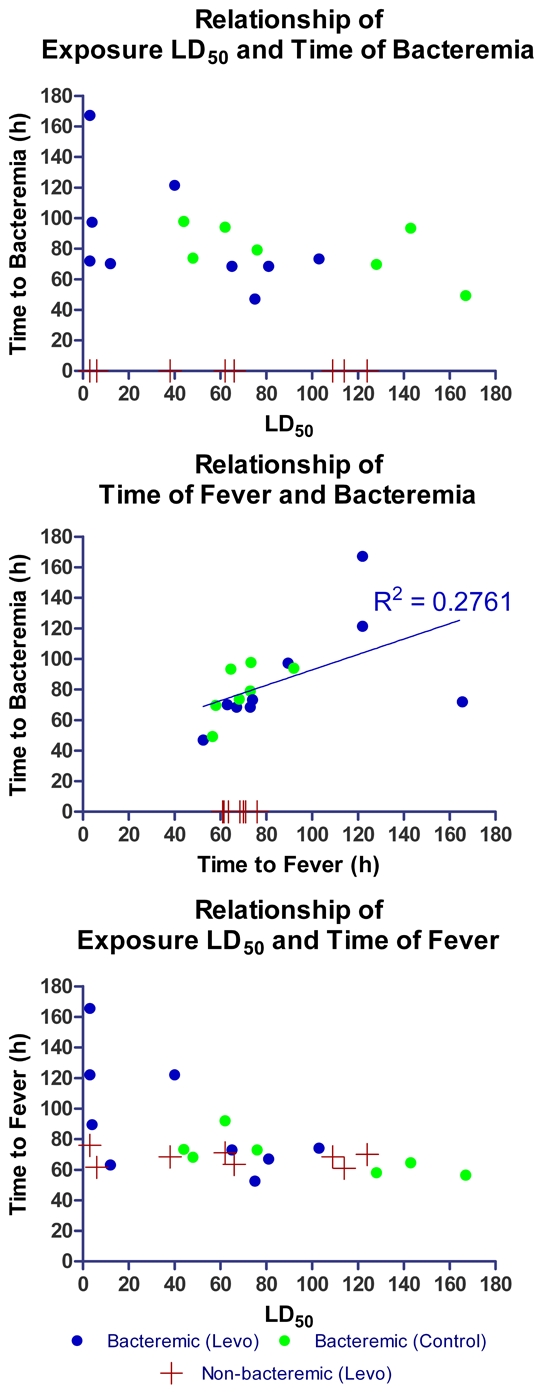
Comparison of time to bacteremia, LD50, and time to fever.Relationships between exposure dose in multiples of LD50 inhaled Y. pestis and onset of fever detected by telemetry and onset of bacteremia detected by culture of once-daily femoral artery blood collections. Time intervals of animals with negative blood cultures are indicated by red crosses. No statistically significant relationships are found between exposure dose, bacteremia and fever onset.